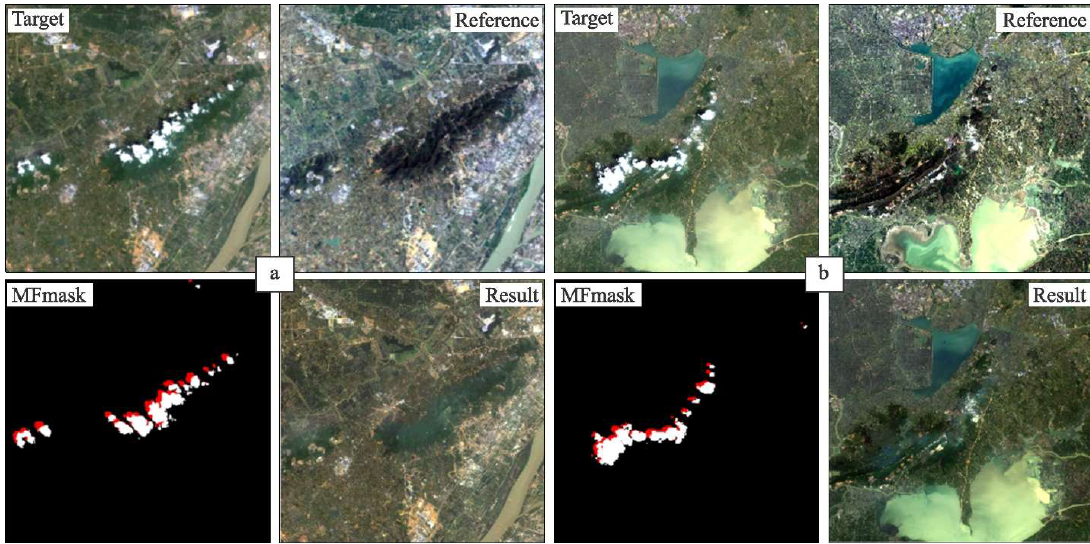
Figure 9. LRM results of a small scattered patch of clouds from Landsat8 OLI image(p120r38_20160429) located in Southeast China near Nanjing City (1000 × 1000 pixel subset). The ( a , b ) are two tests with a relatively larger-scale clouds and cloud shadows shown in Figure 7a of site C and D (composited bands 5, 4 and 3). Upper left shows a subset of Landsat8 OLI image with cloud and cloud shadow cover. Upper right represents the corresponding subset of the reference OLI image (p120r38_20160328). Lower right is the corresponding reconstructed results by the proposed LRM algorithm. Lower left represents the corresponding MFmask results, containing clouds (white), cloud shadows (red) and clear sky (black).